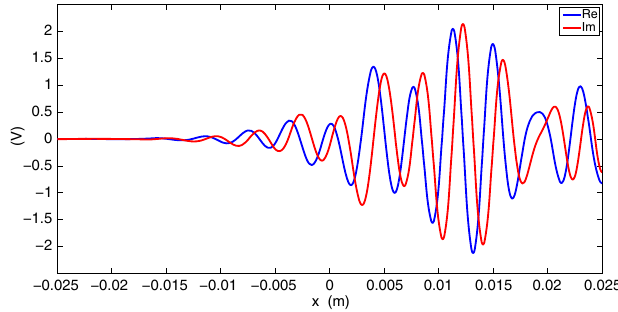
FIG. 7. The sum to p ¼ 9 of the end of the bend ( s ¼ 0 . 55 m) for kR ¼ 2 × 10 6 .